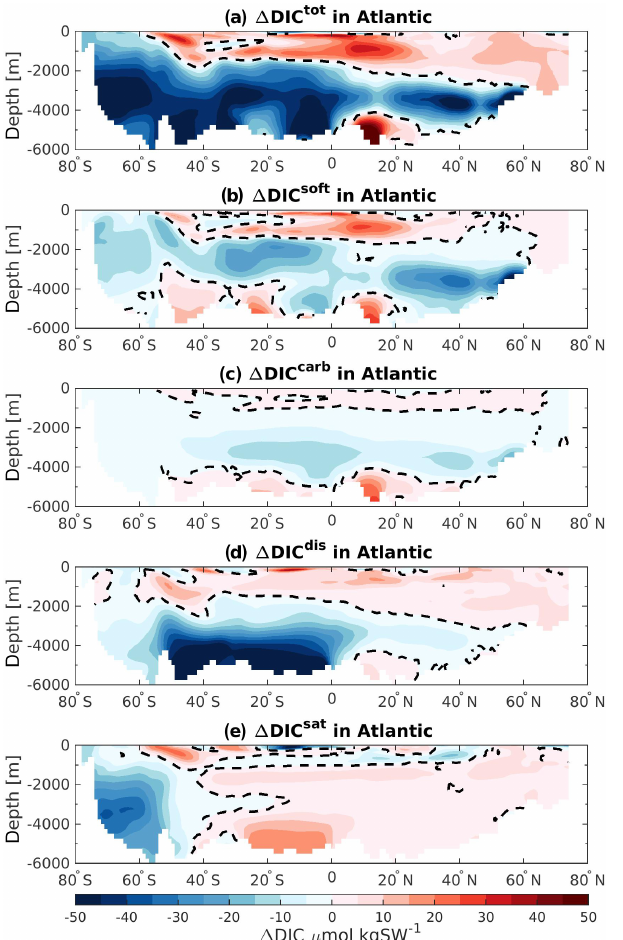
Figure 7. Atlantic zonally averaged section of the difference in (a) (cid:49) DIC tot , (b) (cid:49) DIC soft , (c) (cid:49) DIC carb , (d) (cid:49) DIC dis , and (e) (cid:49) DIC sat between 125 and 115ka. The black dashed lines repre- sent the zero values.